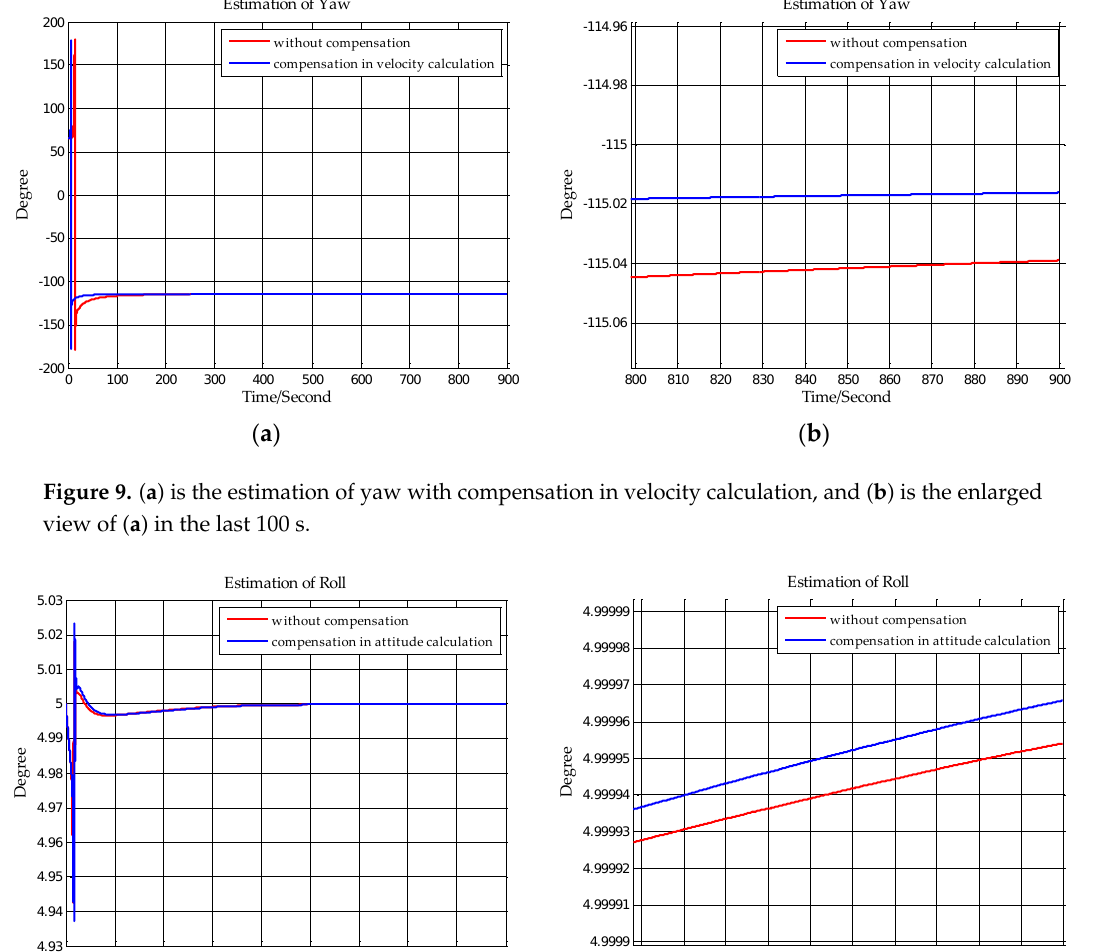
( b ) Figure 11. ( a ) is the estimation of pitch with compensation in attitude calculation, and ( b ) is the enlarged view of ( a ) in the last 100 s. ( a ) ( b ) Figure 12. ( a ) is the estimation of yaw with compensation in attitude calculation, and ( b ) is the enlarged view of ( a ) in the last 100 s.